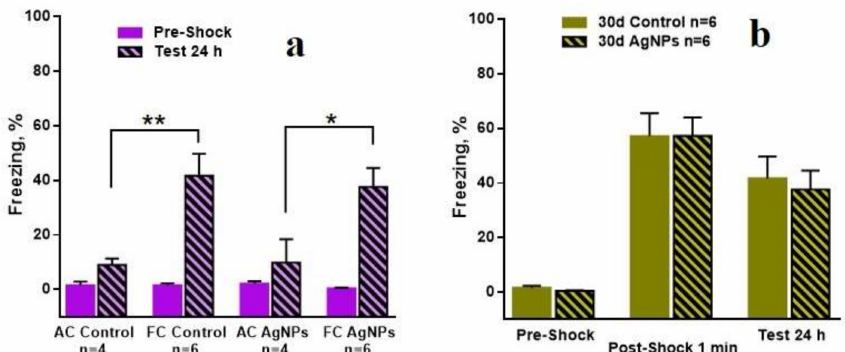
Figure 12. Number of the freezing acts in the Freezing chamber for “30 day” group of mice. ( a ) demonstrates the quality of learning for the Ag-NP groups and the reference groups between the fear conditioning (FC) and the active control (AC); ( b ) is the comparison in the learning and the formed contextual memory between the Ag-NP groups and the reference groups.